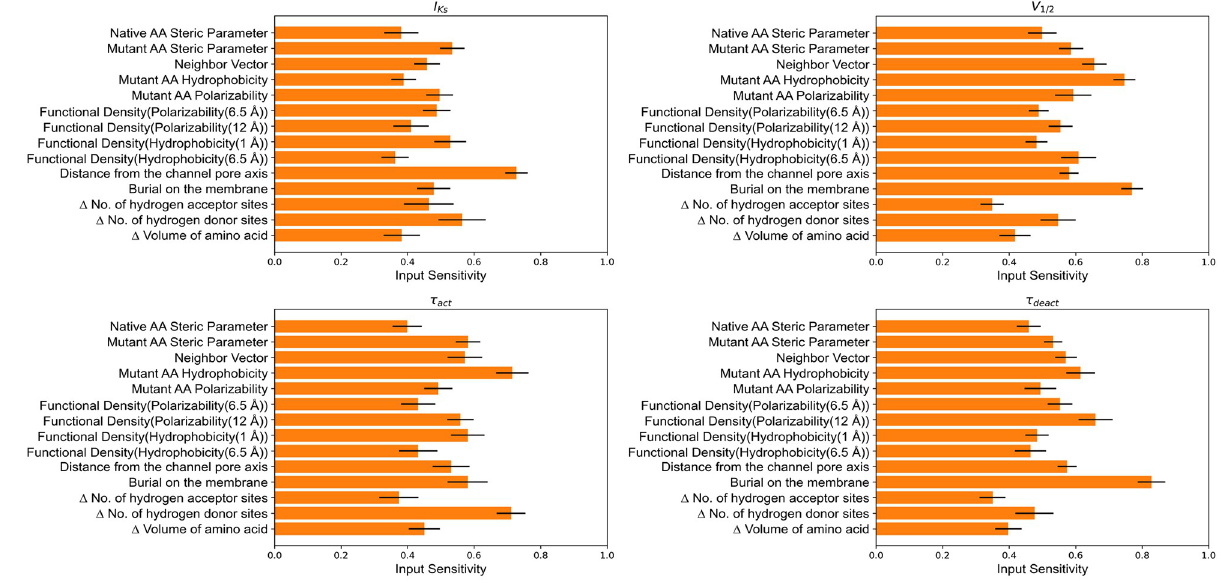
Fig 5. Average input sensitivities for ANN model trained with only biophysical